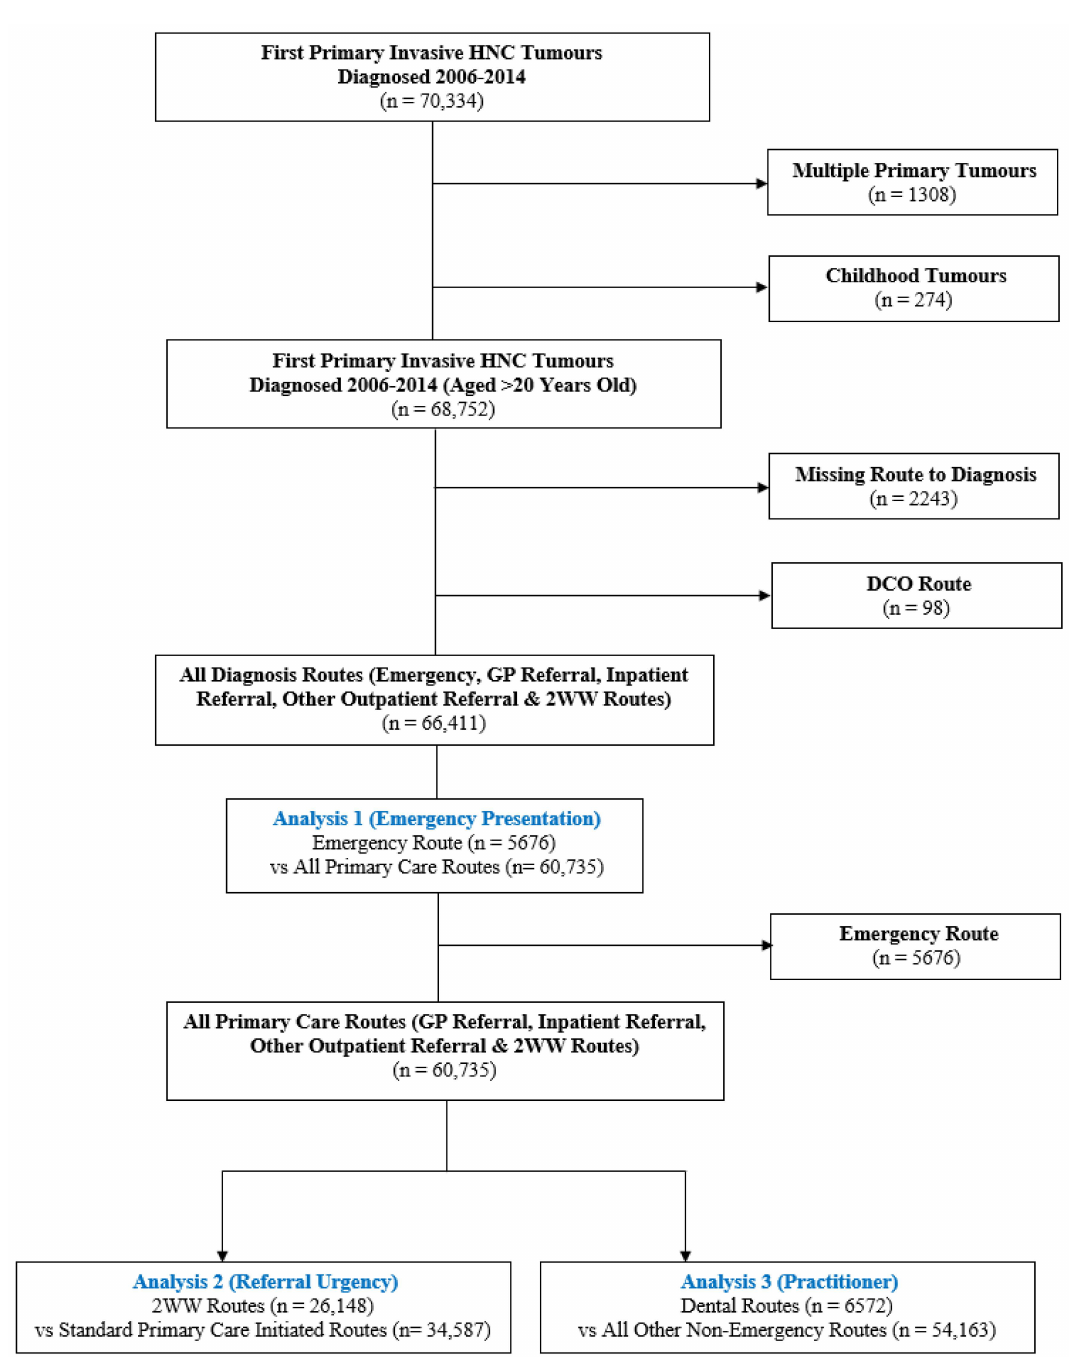
Figure 1. Flow diagram of the analytical cohorts for Analyses 1–3. Abbreviations: DCO: